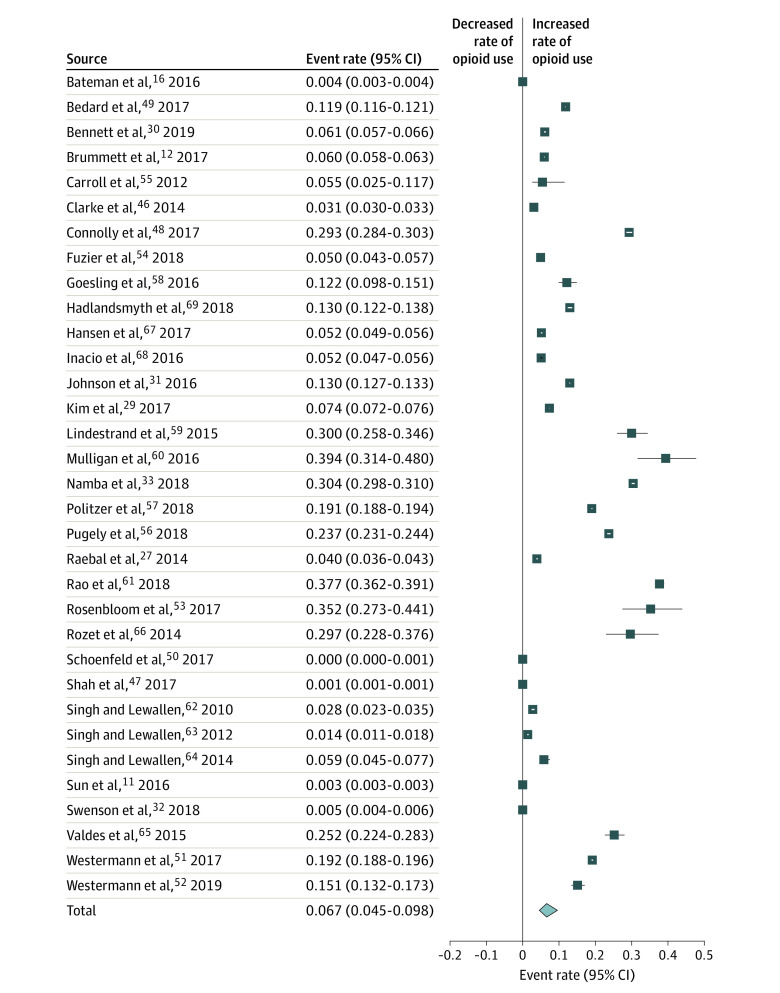
Forest Plot of Studies Assessing Prolonged Opioid Use After SurgerySquares indicate event rates, with horizontal lines representing 95% CIs. The diamond represents the pooled total, with the points of the diamond representing 95% CIs. The data show substantial between-study heterogeneity (P < .001; I2 = 99.96%).